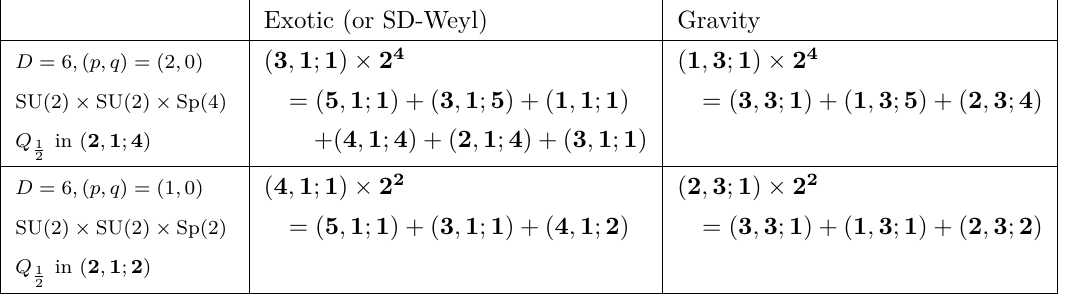
Table 2 . Six-dimensional SD-Weyl vs. gravity